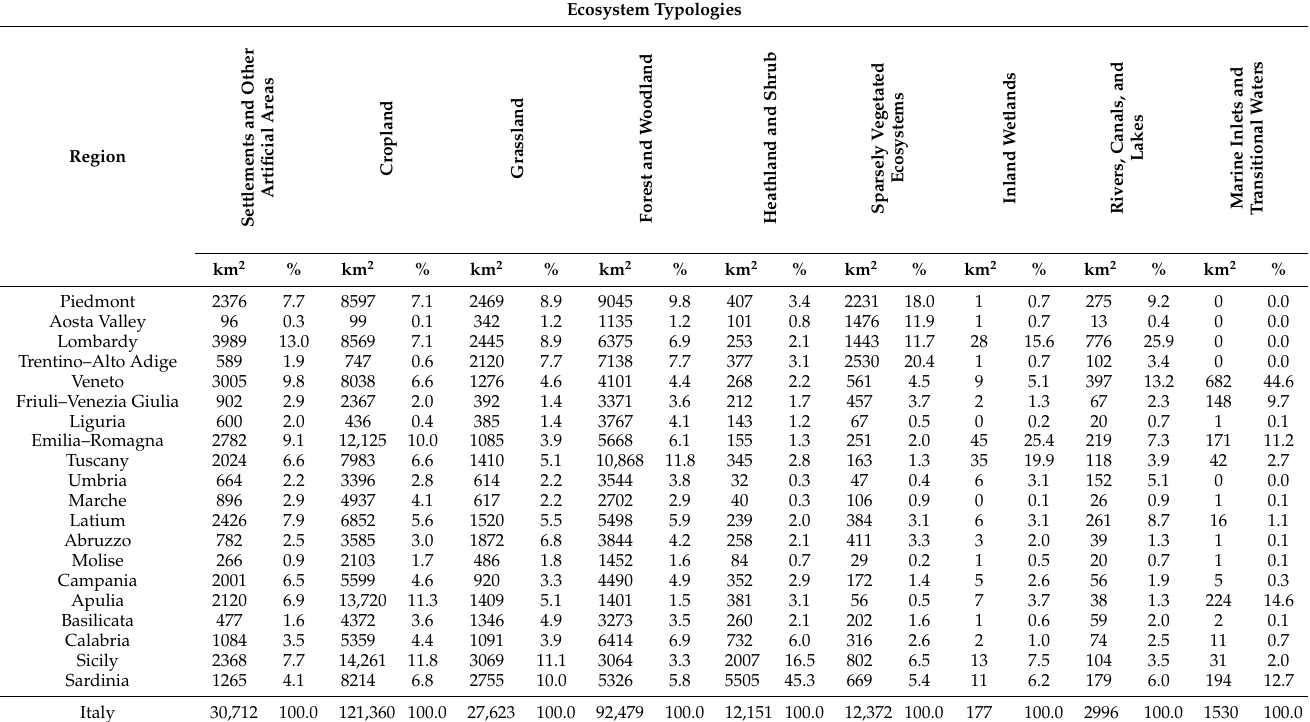
Table 4. Surface statistics relating to the ecosystem typologies map for the Italian territory